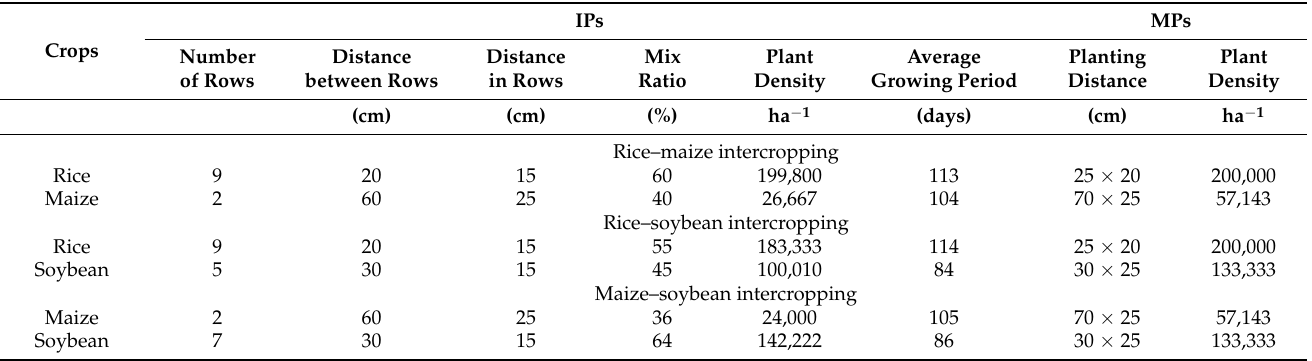
Table 2. The number of rows, distance between rows, distance in rows, mix ratio, and expected plant density under different IPs and MPs in drylands of western Indonesia with a wet climate. IPs